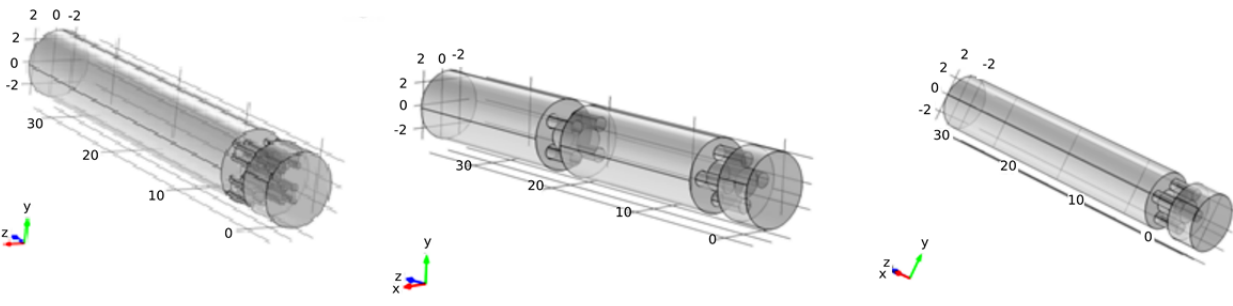
Figure 8. Fractal cross-section of the first iteration of a circle through which current flows ( right ), Fractal cross-section of the first iteration of a circle through which current flows twice with zero and 45 degrees ( center ), Fractal cross-section of the second iteration of a circle through which current flows ( left